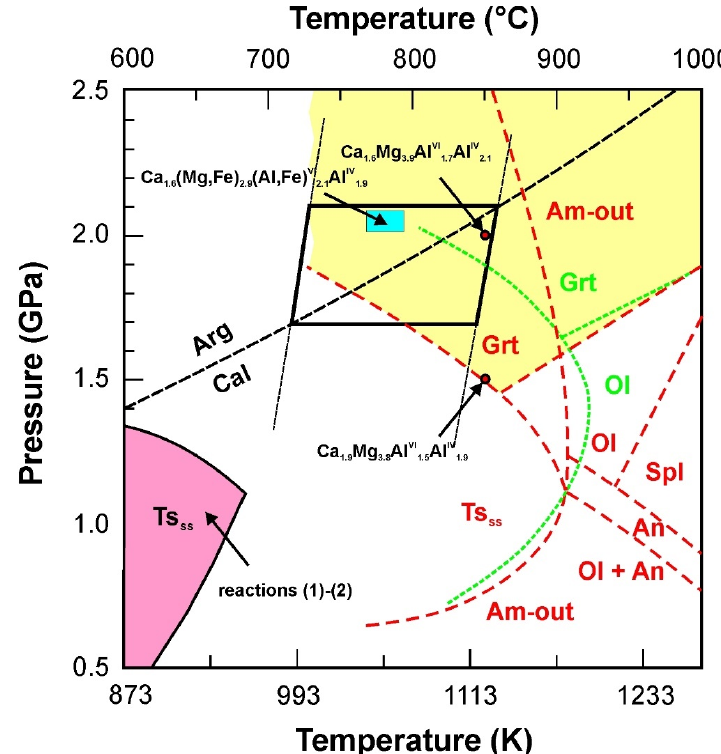
Figure 18. Summary of PT constraints obtained from the ilmenite-olivine thermometer [53,54] (trapezoid area), equilibrium coordinates of reactions (1) and (2) calculated for various X CO 2 values (pink area), calcite-aragonite stability boundary (diagonal thick-dashed curve), plagioclase-amphibole thermobarometer [57] (blue square) applied to amphibole (analysis #9, Table 2) coexisting with An 87.5 plagioclase, and phase boundaries inferred from experimental data [73] (green stippled curves for ferritschermakite, red dashed curves for tschermakite sensu stricto—Ts ss ). Red dots indicate compositions of Al-rich amphiboles coexisting with garnet at 1.5 and 2.0 GPa [73]. Thermodynamic calculations were made using the PERPLE_X 07 program [74,75], pure compounds involved in thermodynamic database [76], and compensated‐Redlich–Kwong equation of state (CORK EOS) for H 2 O‐CO 2 fluids adapted for high pressures [77]. Mineral abbreviations [30]: Am—amphibole, An—